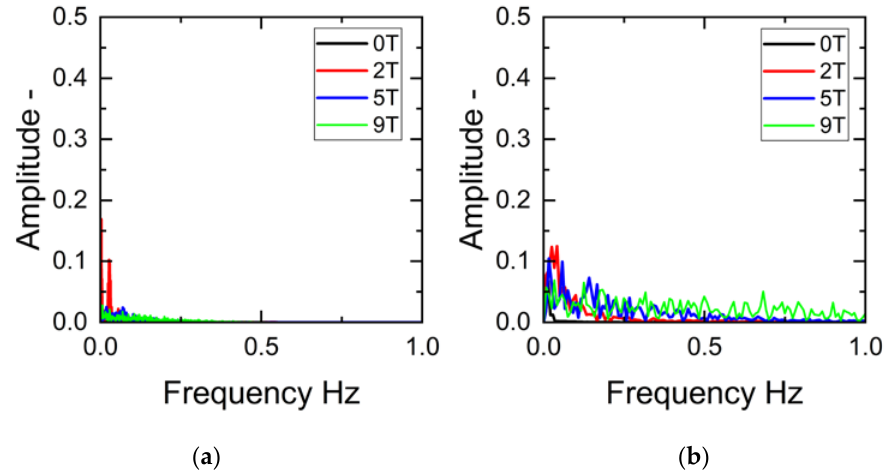
Figure 6. Fast Fourier transform of temperature results for the case with Δ T = 5 °C—( a ) experimental and ( b ) numerical.